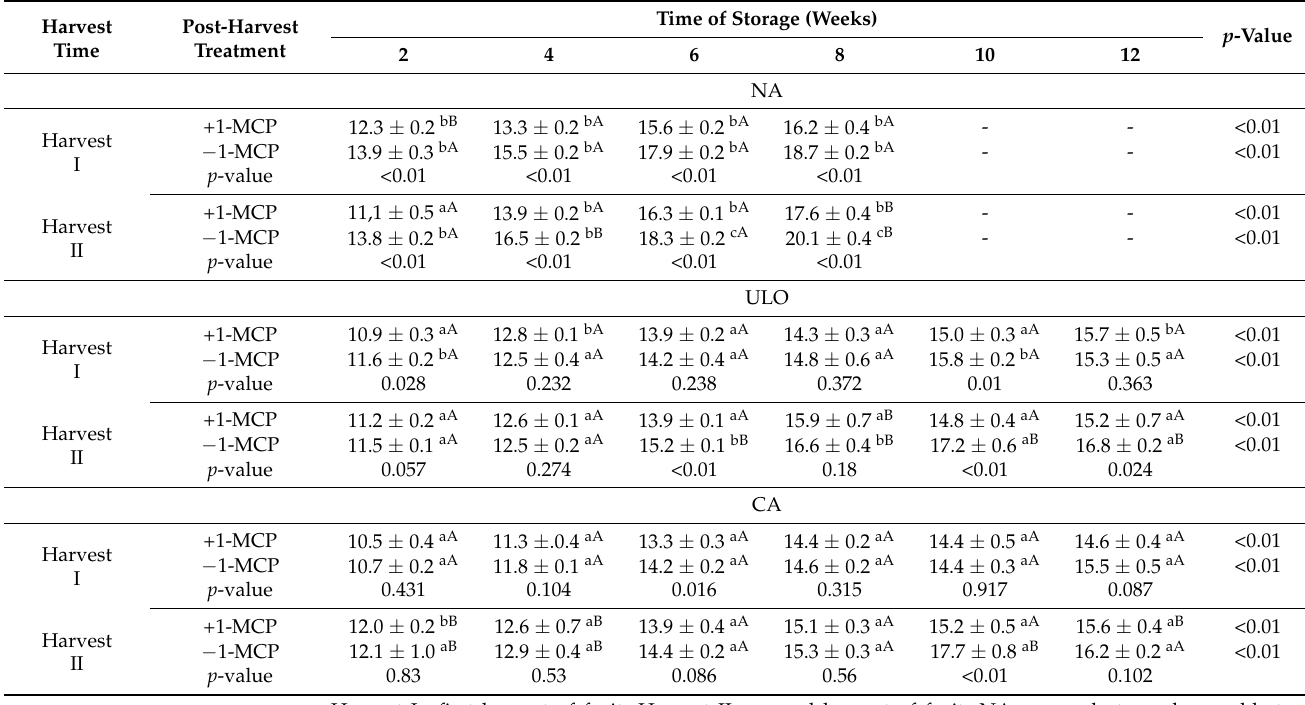
Table 4. Changes of solids soluble content ( ◦ Brix) measured in ‘Geneva’ mini kiwi fruit in the post-harvest